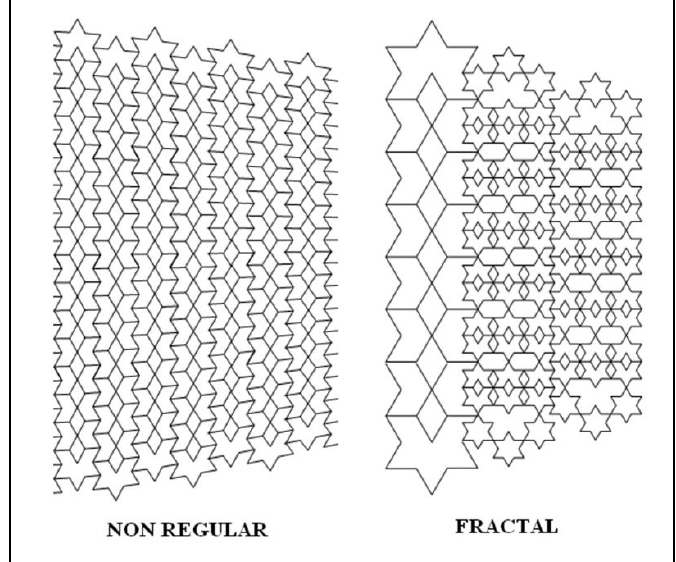
Figure 18. Dimensional variation of auxetic structure n.3 in a non-regular system or in a fractal